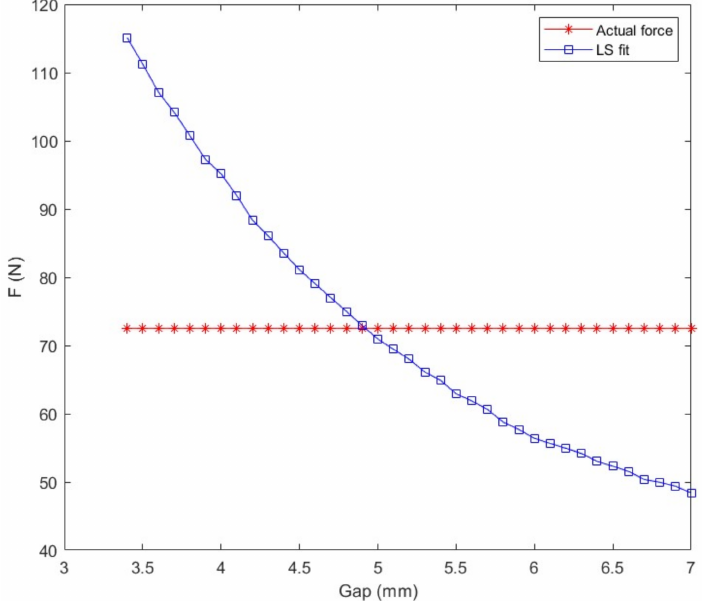
Figure 4. Comparison of the actual electromagnetic force and the electromagnetic force estimated by Equation